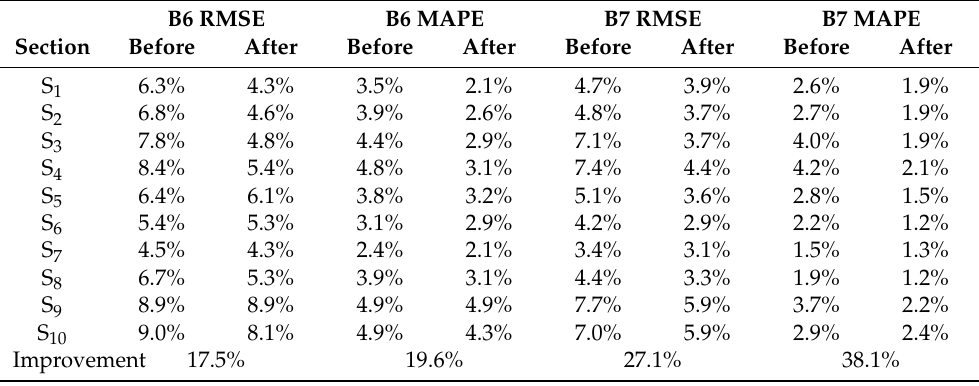
Table 4. Comparison of capacity estimation before and after BCT (NASA dataset).